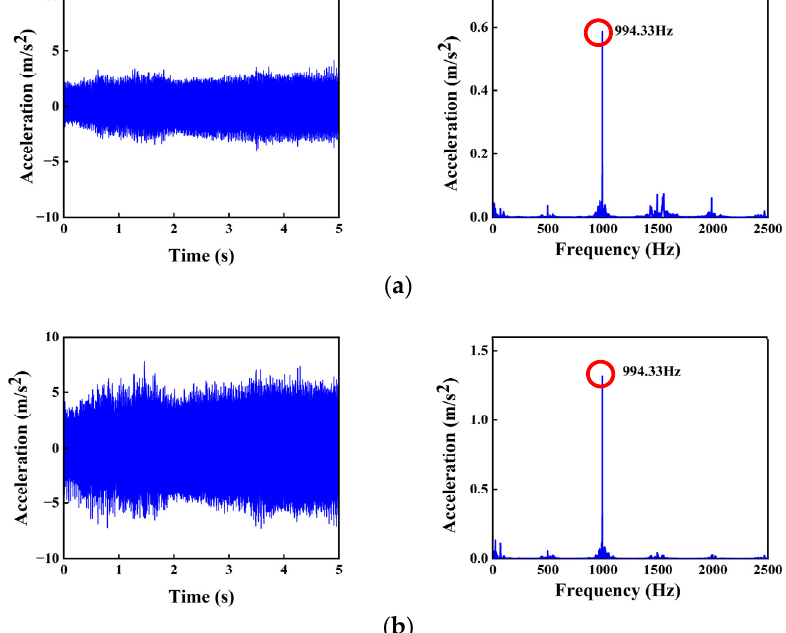
Figure 6. Time domain and frequency domain of vibration acceleration at 20 km/h maglev train speed: ( a ) lateral and ( b ) vertical.